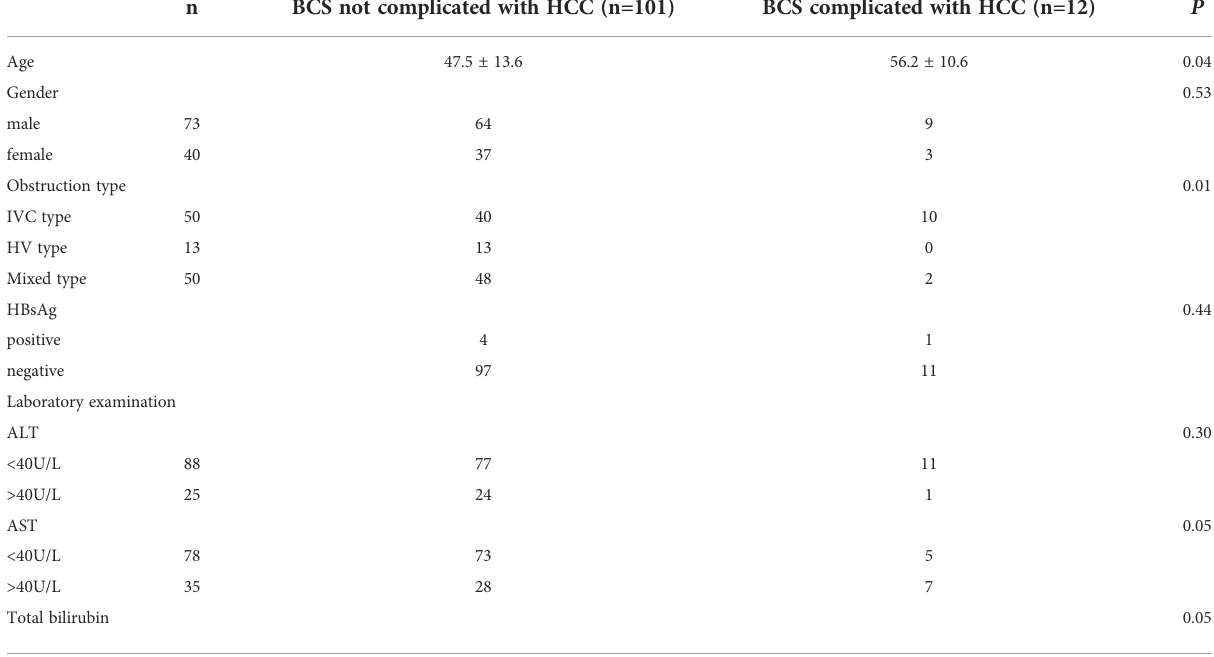
TABLE 4 Comparison of clinical data between patients complicated with HCC and not complicated with